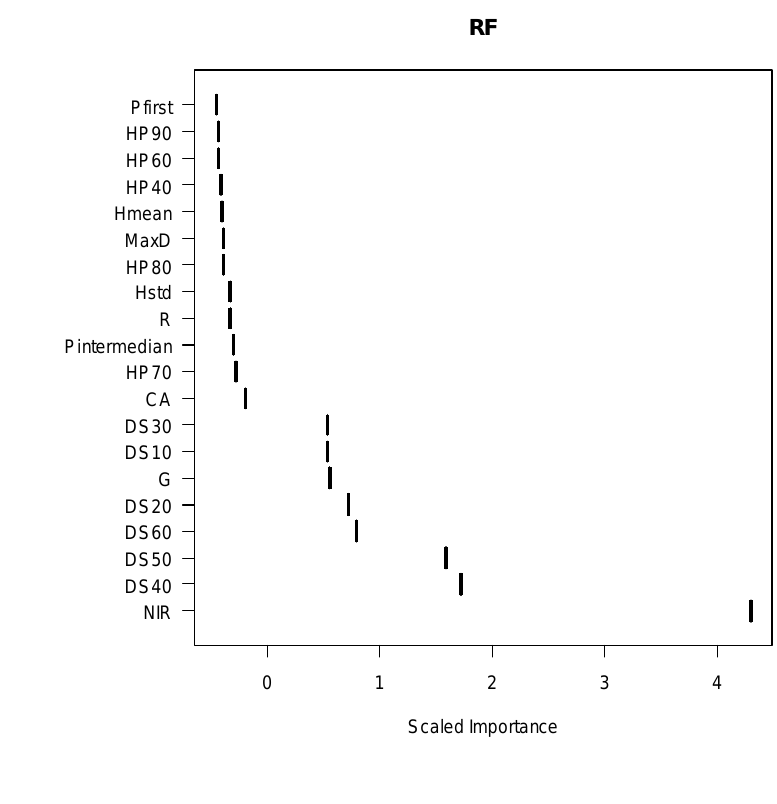
Figure 4. Importance of features in classifying defoliated trees using RF. Higher values indicate features that are more important to the classification. For feature descriptions, see Table